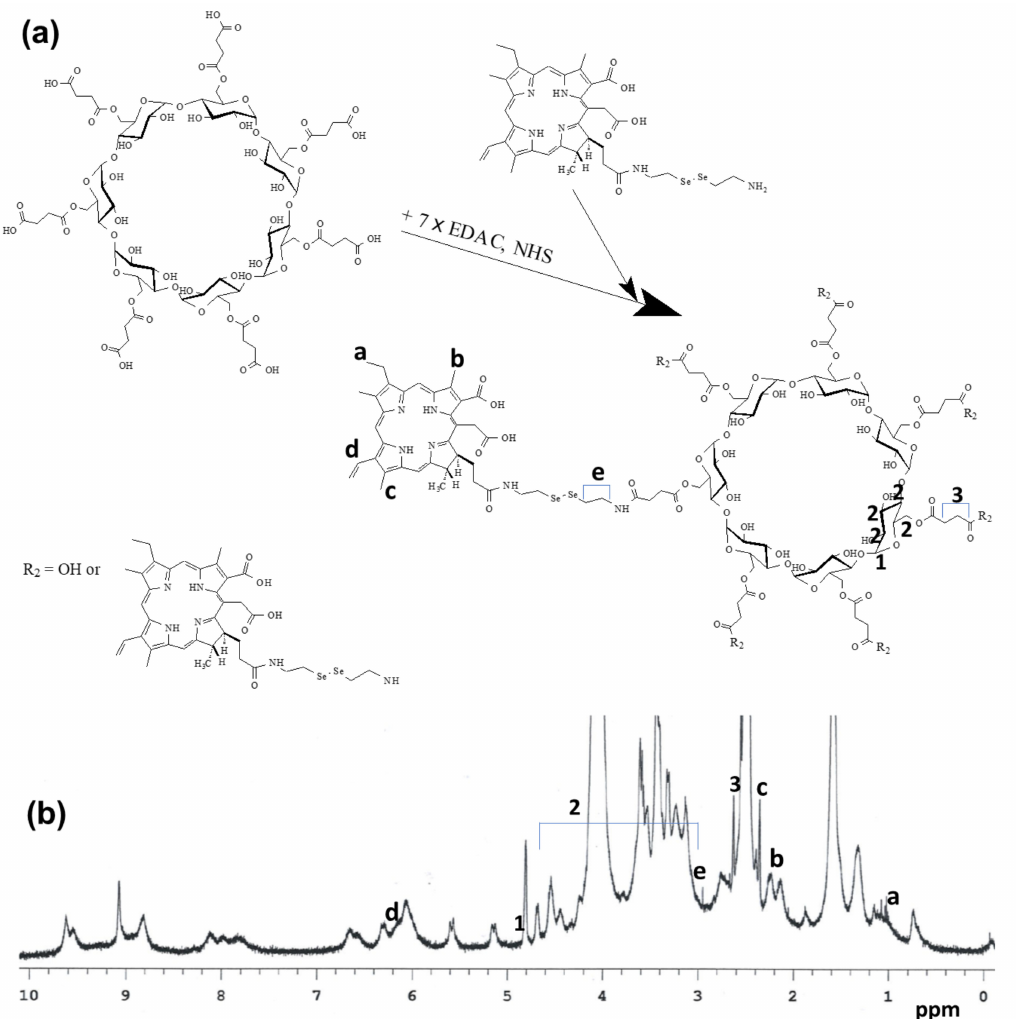
Figure 1. Synthesis scheme ( a ) and 1 H NMR spectra ( b ) of succinyl β -cyclodextrin-selenocystamine-Ce6 conjugates. Succinyl β -cyclodextrin-selenocystamine-Ce6 conjugates was dissolved in dimethyl sulfoxide (DMSO)-d form to measure the chemical structure with 1 H NMR